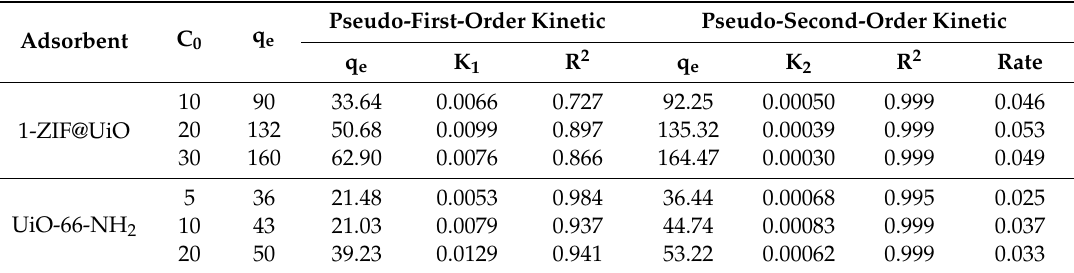
Table 4. Values of the kinetic parameters for 1-zeolitic imidazolate framework-8 (ZIF-8)@UiO-66-NH 2 and UiO-66-NH 2 .